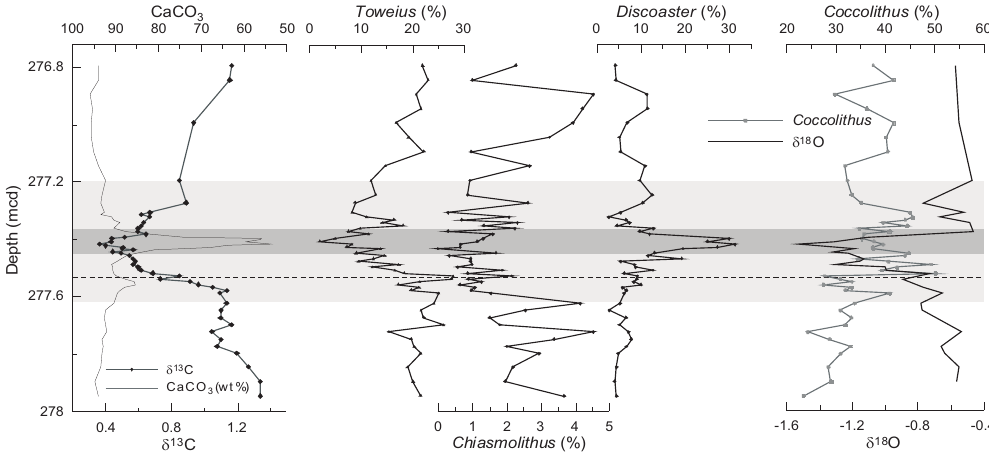
Fig. 7. The δ 13 C (black rhomboids) and the carbonate content (grey line) plotted against the relative abundances of Toweius , Discoaster, Chiasmolithus and Coccolithus pelagicus in correlation with the δ 18 O measured in the 5–8µm size fraction (Dedert et al., 2012). Dark grey bar indicates Elmo horizon, light grey bar indicates the CIE. The interval of the salient increase in Coccolithus abundance is marked by a dashed grey